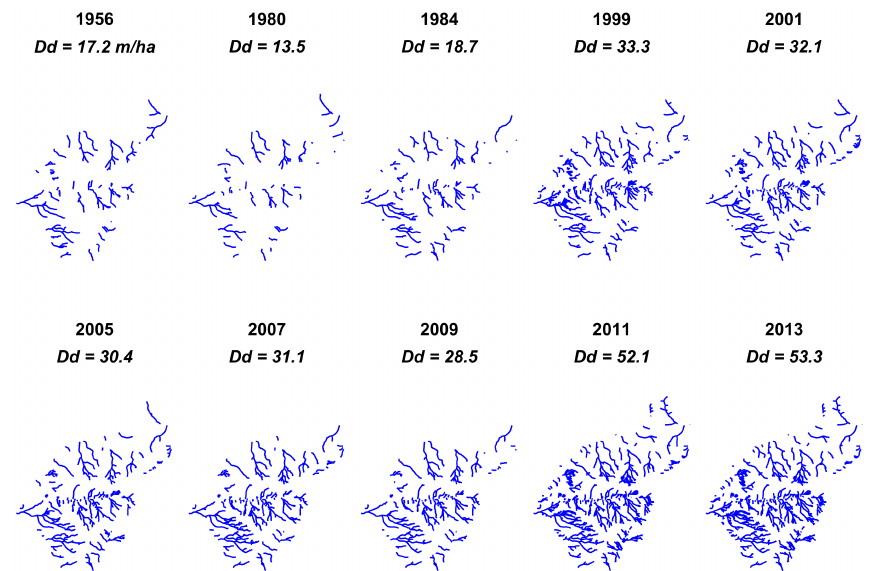
Figure 9. Gully network evolution and drainage density ( D d ), in mha − 1 , at each period.